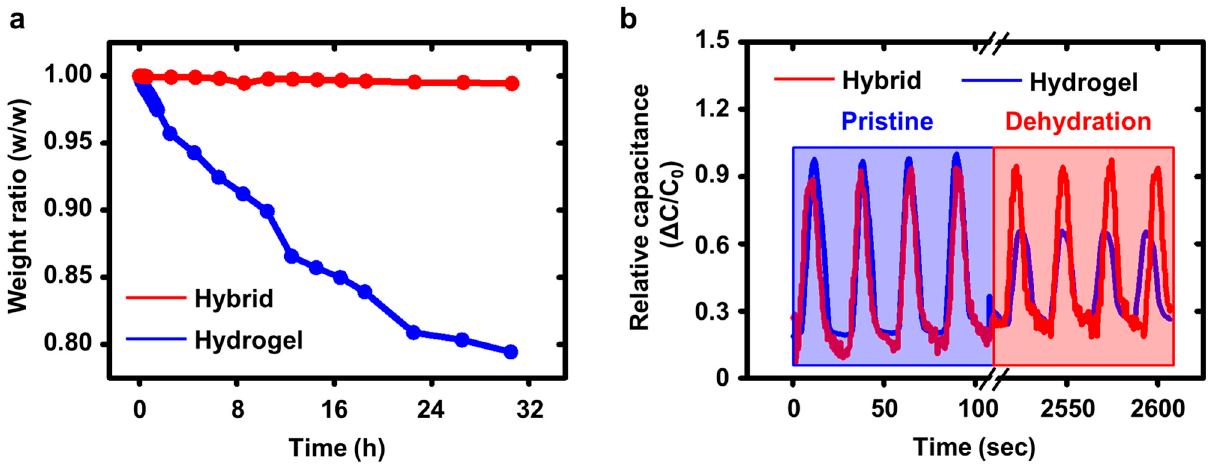
Figure 4. ( a ) Comparison of the pressure sensing durability of the HPS to that of HPS without HFP encapsulation. ( b ) Pressing cyclic data of the HPS.